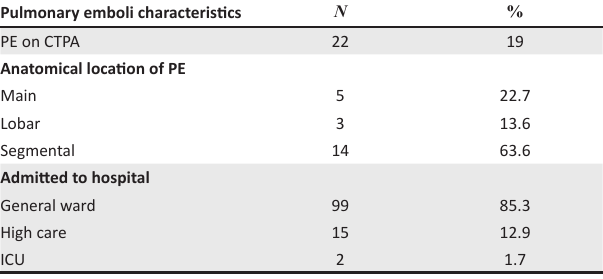
TABLE 1: Pulmonary emboli characteristics.